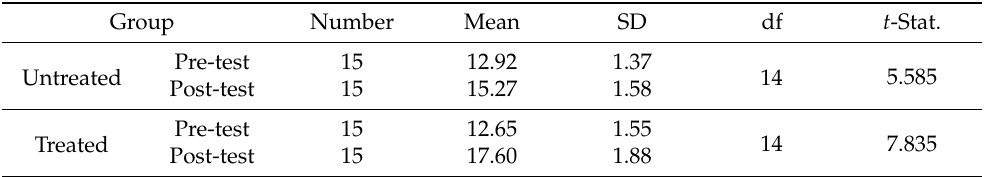
Table 1. Descriptive statistics of the untreated and treated groups. Group Number Mean SD t -Stat.